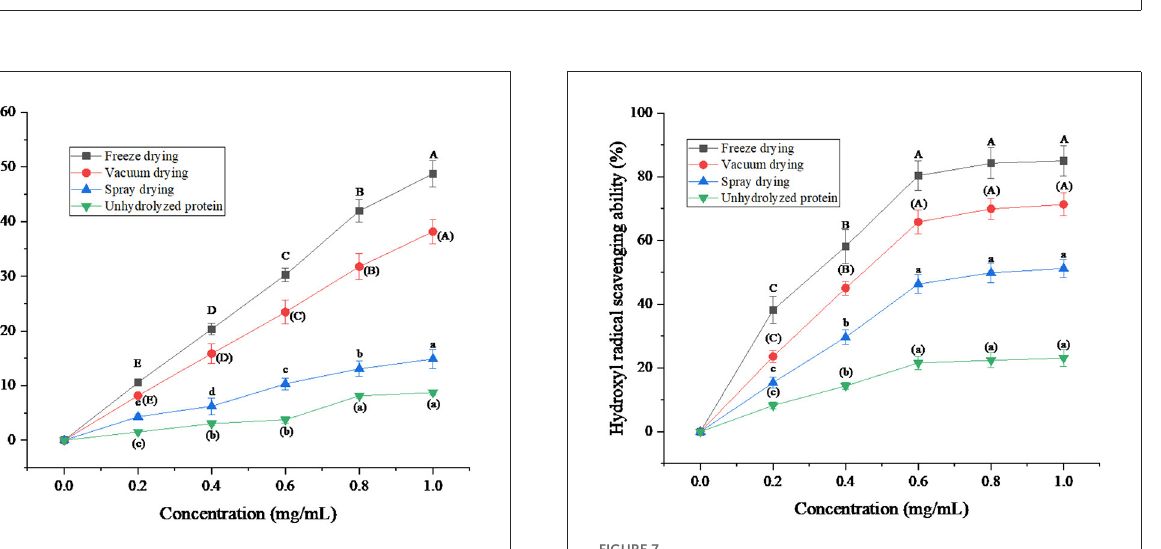
FIGURE6 Superoxide anion (O2- · ) scavenging ability of protein peptide powder by three dry methods. Different letters express significant differences ( p < 0.05).